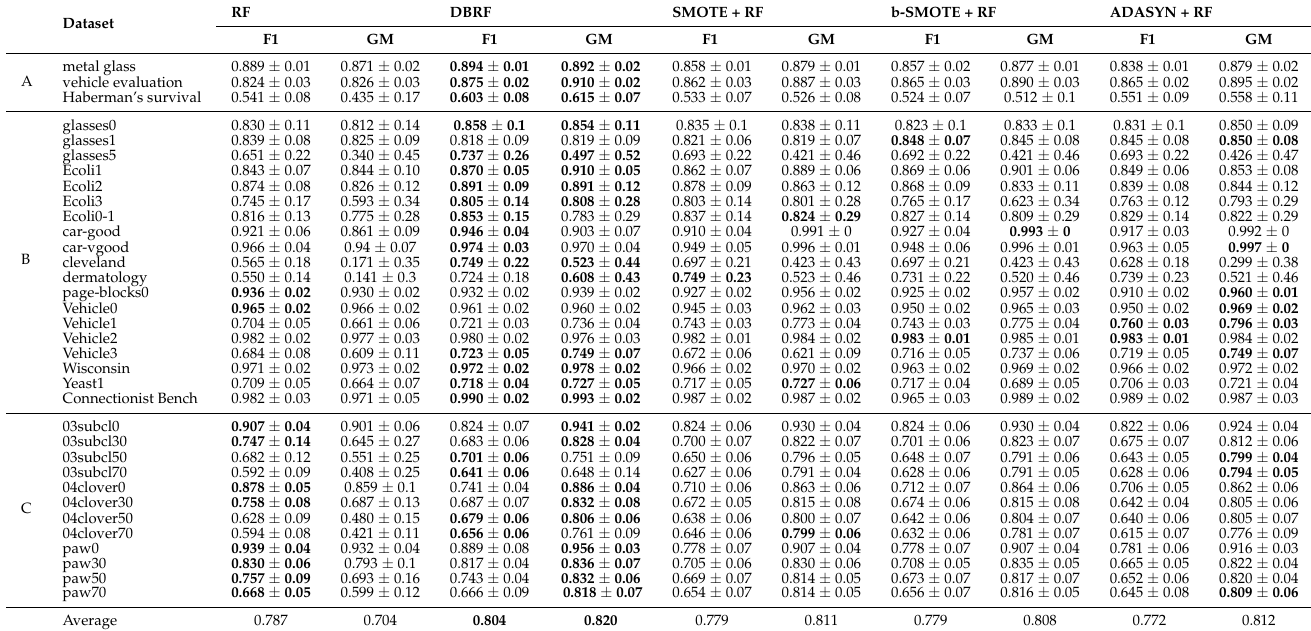
Figure 9. Averaging AUC curve and ROC of metal glass. Table 3. Comparison of random forest, SMOTE + RF, b-SMOTE + RF, ADASYN + RF, and DBRF on three dataset categories. The bold results in the table are optimal after 10-fold cross-validation. DBRF’s parameter values are size = 100, ω = 10, p = 0.4–0.6, and η = 0.5–50. RF denotes random forest. SMOTE + RF signifies that each dataset was balanced with SMOTE, then classified with RF. b-SMOTE + RF signifies that each dataset was balanced with borderline SMOTE, then classified with RF. ADASYN + RF signifies that each dataset was balanced with ADASYN, then classified with